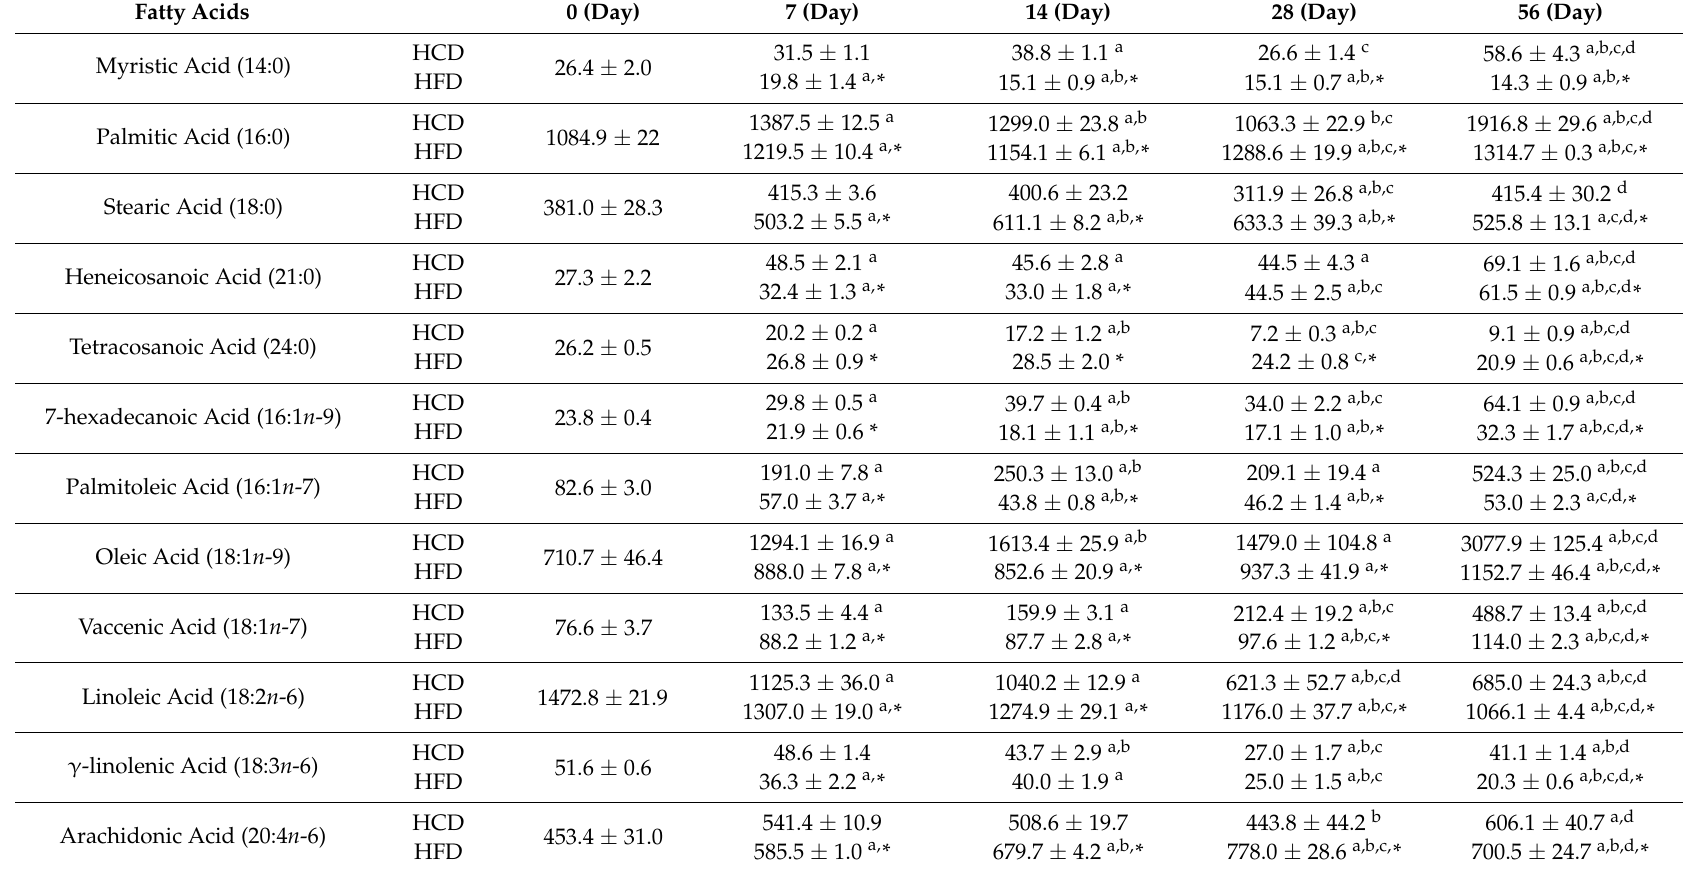
Table 2. Fatty acid composition (mg 100/g of sample) in the liver from mice fed with High-carbohydrate diet (HCD) or High-fat diet (HFD) diet at 0 (before starting the diets), or after 7, 14, 28 or 56